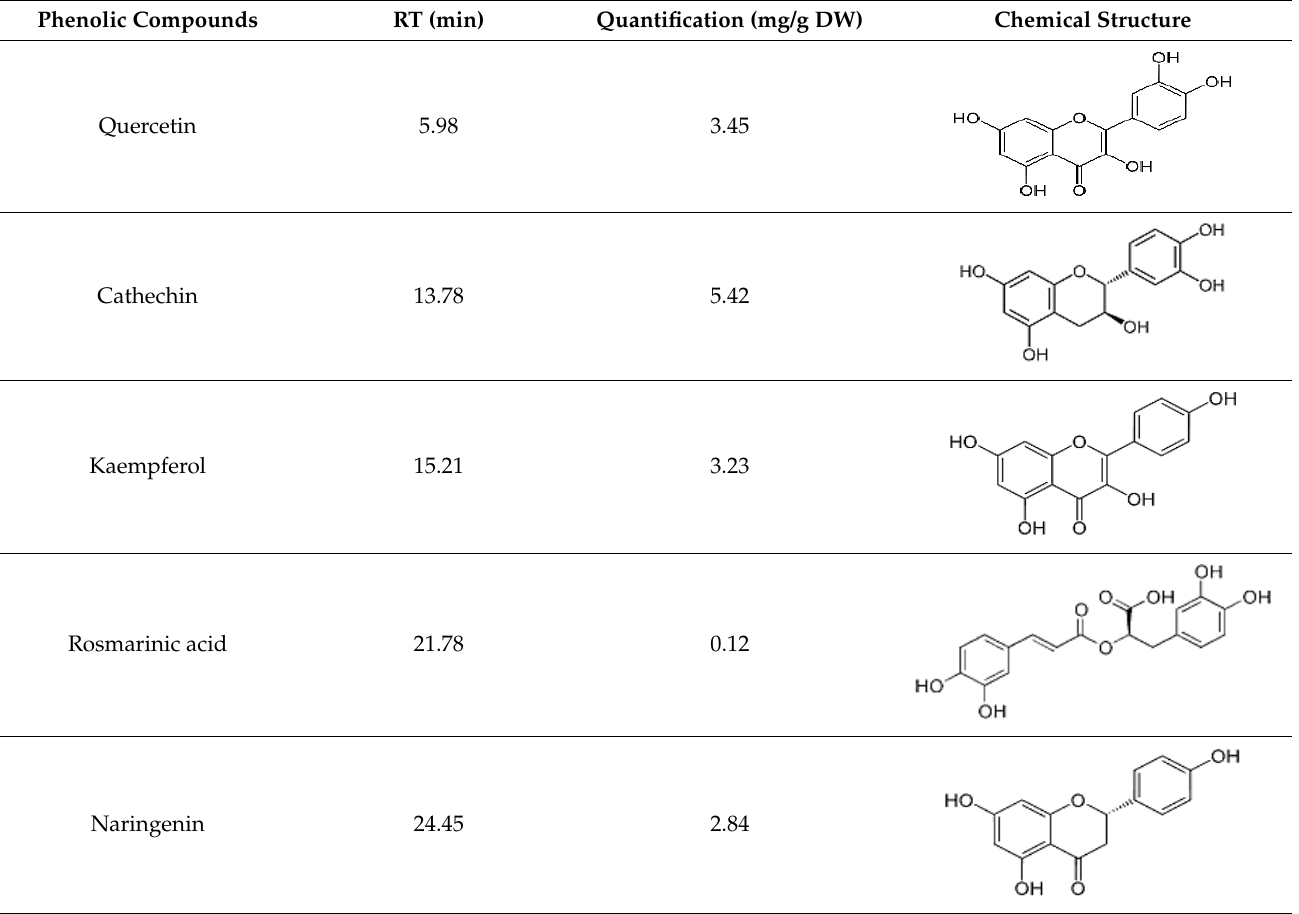
Table 2. Phenolic compounds identified in Cleome fruits extract by HPLC.